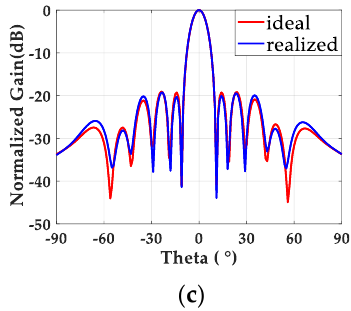
Figure 8. ( a ) One-to-six-way uniformly powered and spaced power divider. ( b ) 2-to-12 non-uniformly powered and spaced divider. ( c ) Normalized gain along theta ( θ ) of the 12 patch elements individually fed by the realized amplitudes and phases from the designed power divider and the ideal values. Table 3. Phase delays from ports 4, 6, 8, 10, 12 and 14 after tuning L1 and L2, and adding the meander lines in the one-to-six power divider, as shown in Figure 7a.